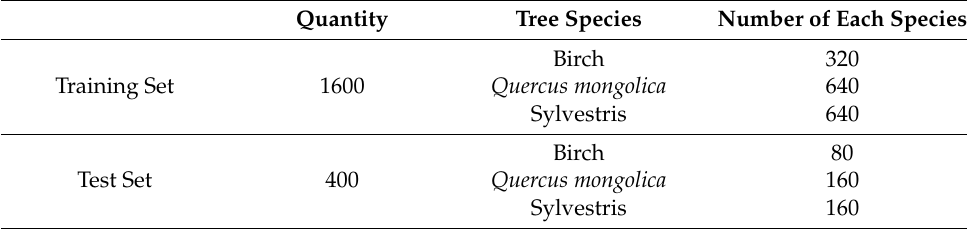
Table 2. Data set